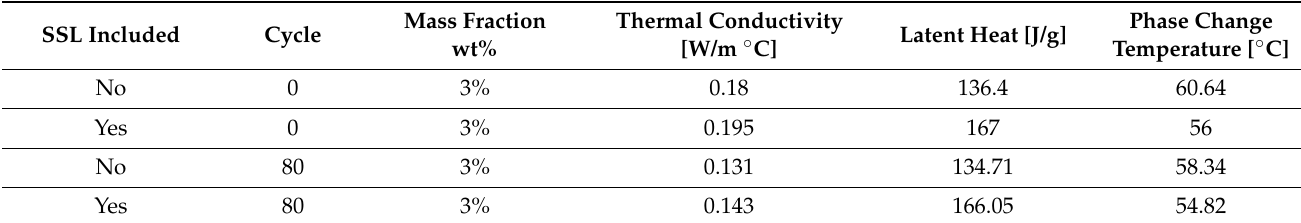
Table 3. Comparison of thermal properties of paraffin/TiO 2 NEPCM with and without sodium stearoyl lactylate (SSL) before and after 80 thermal cycles [60].